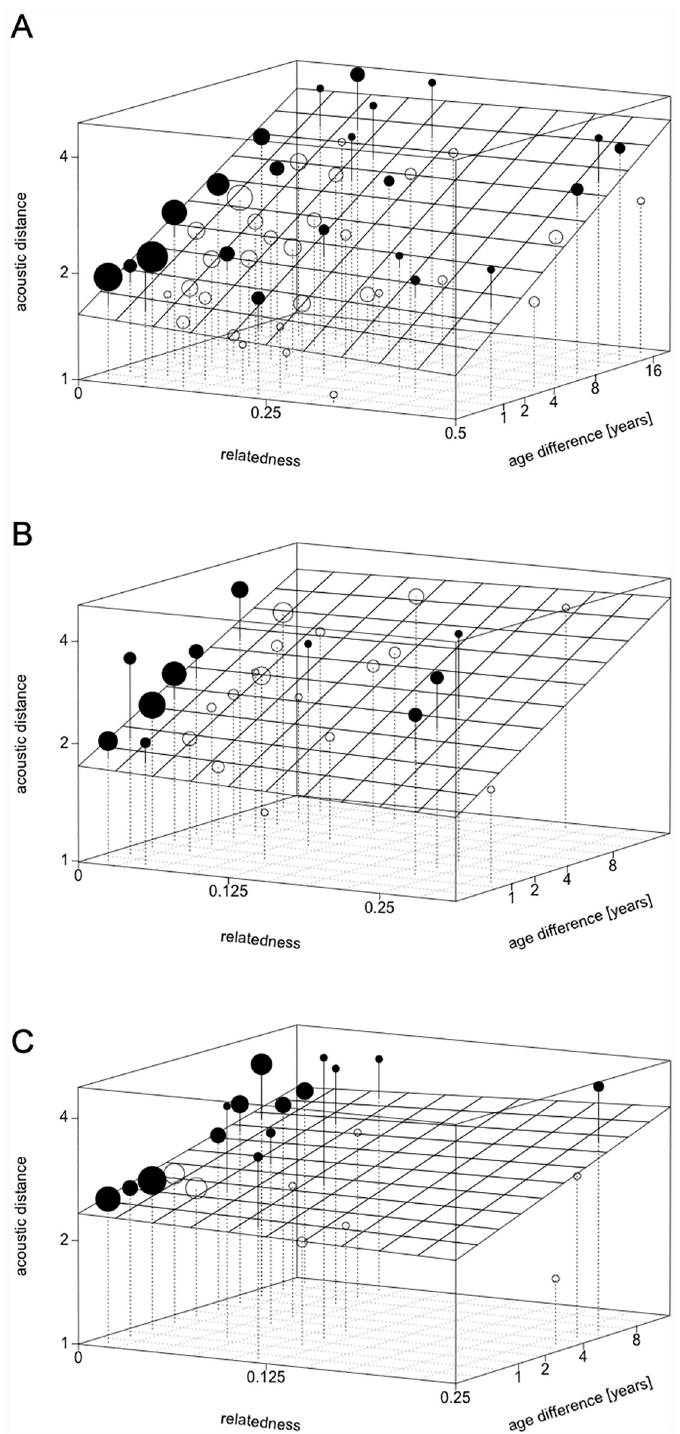
Fig 2. Acoustic distance vs. relatedness and age difference, plotted for the three levels of group- matrilineal membership. Acoustic distance plotted against relatedness and age difference for the three different levels of group-matrilineal membership: (A) same group & same matriline, (B) same group & different matriline, (C) different group & different matriline. The grid indicates the predictions of the model, while circles indicate actual data points. The area of a circle represents the number of data points plotted, and the color indicates whether the data points fall above (black) or below (white) model prediction.